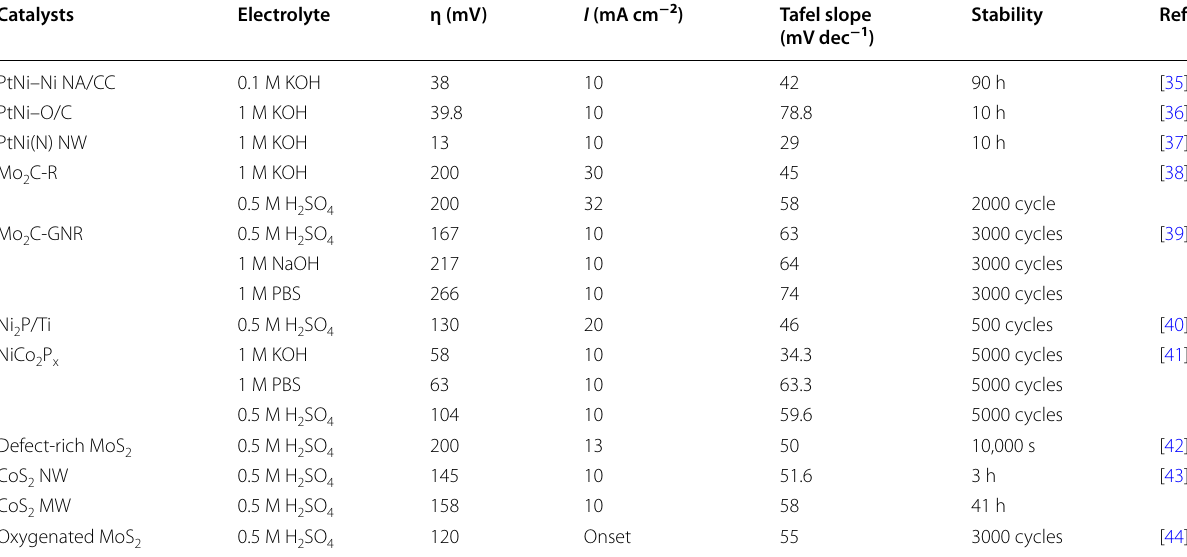
Table 1 Summary of the HER performance of the reported electrocatalysts